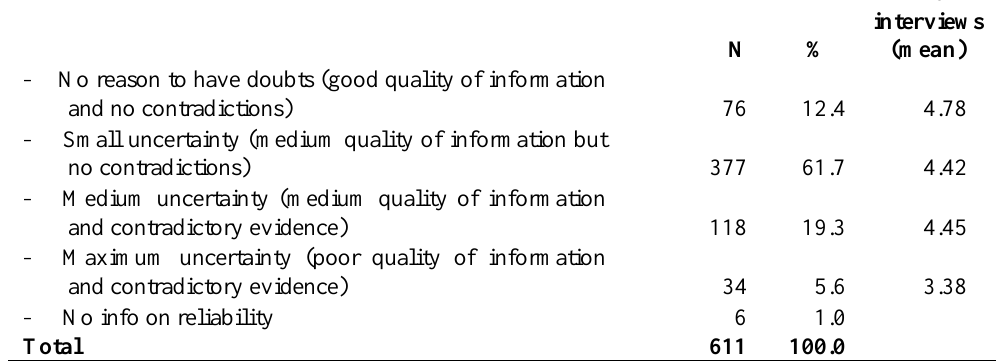
Reliability of information at the policy proposal